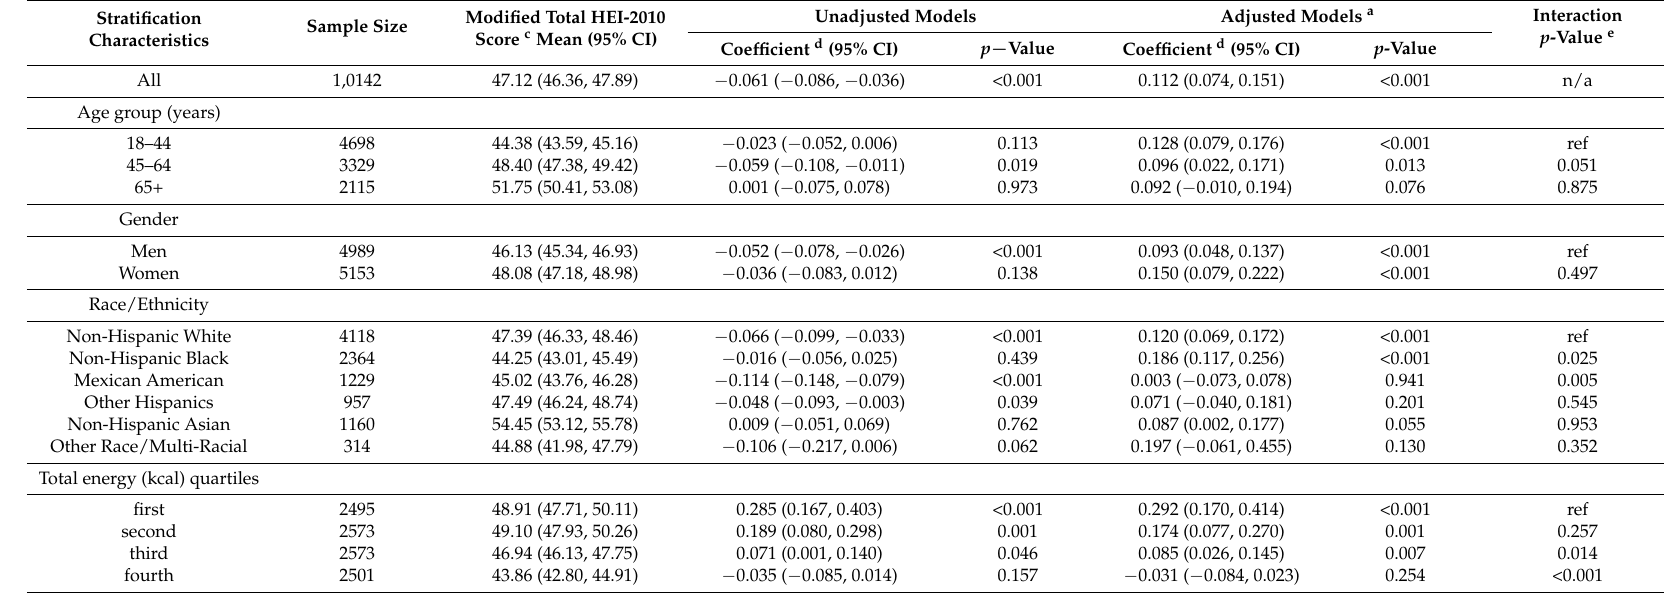
Table 4. Stratified unadjusted and adjusted a linear regression coefficients ( β ) from analyses of total sodium b (per 100 mg/day) with modified total HEI-2010 score c (dependent variables)—National Health and Nutrition Examination Survey,